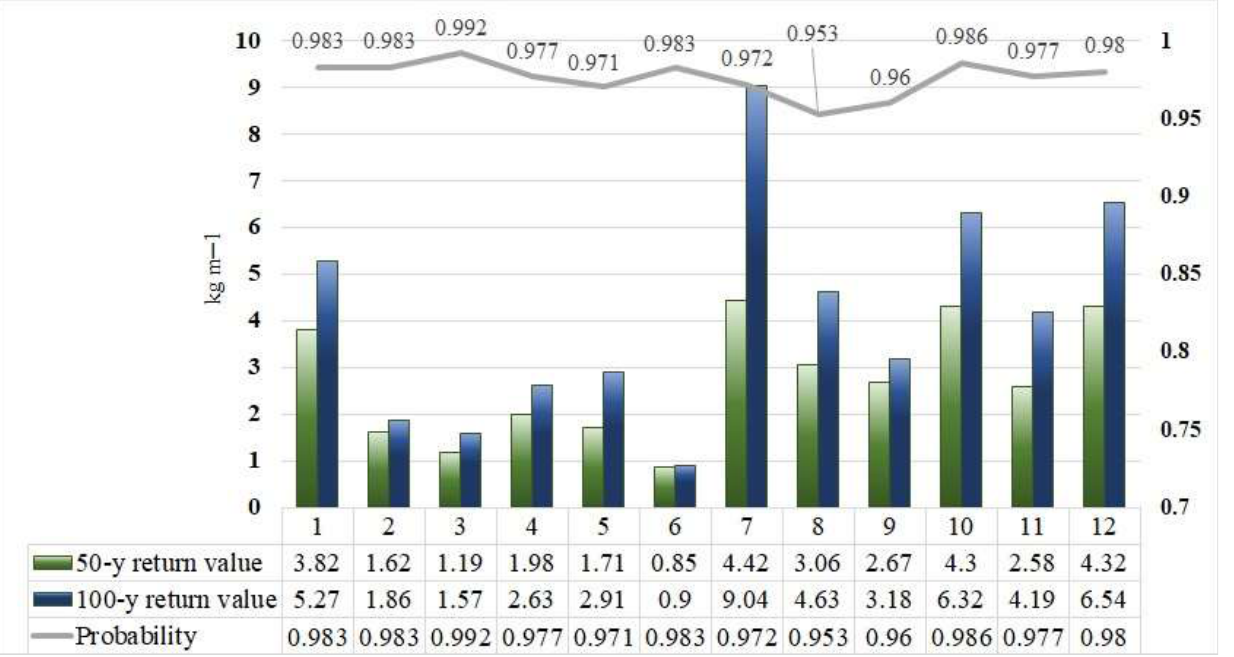
Figure 9. 50-year and 100-year return value of wet snow mass (kg·m −1 ) and the probability of the 50-year return value calculated from the estimated wet snow mass (kg·m −1 ) between 1965–1990. See the explanation of station labels 1–12 in Table 1.